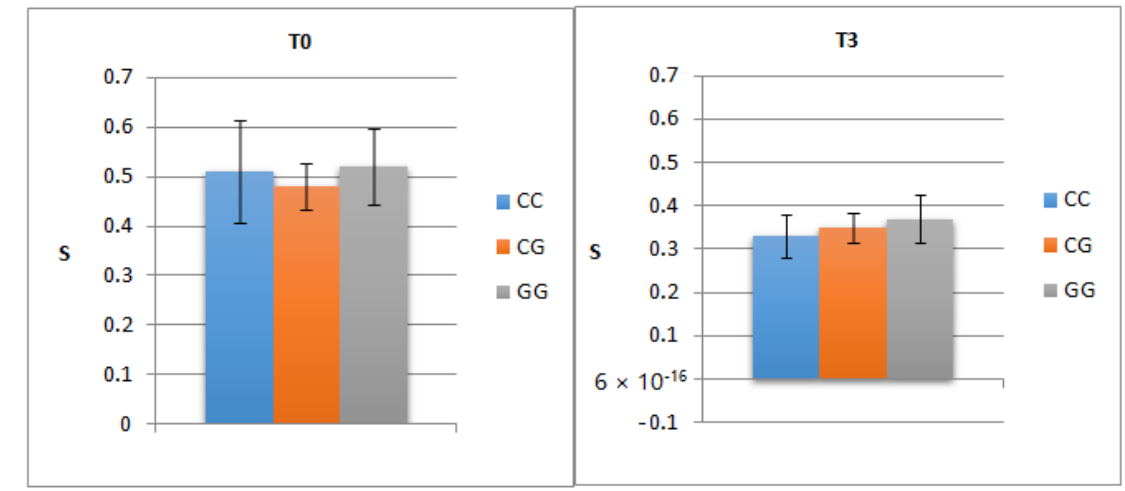
Figure 2. Correlation of pre- and post-treatment steatosis (three months post-SVR) with PNPLA3 genotype.T0—the initial visit; T3—the second visit; PNPLA3—patatin-like phospholipase domain-containing3; S—steatosis. The distribution of steatosis and fibrosis three months post-SVR correlated with PNPLA3 is presented in Table 5. Table 5. Mean ± SD valuesof steatosis and fibrosis after treatment(three months post-SVR) according to PNPLA3 genotype(Bonferroni post hoc test post-SVR).